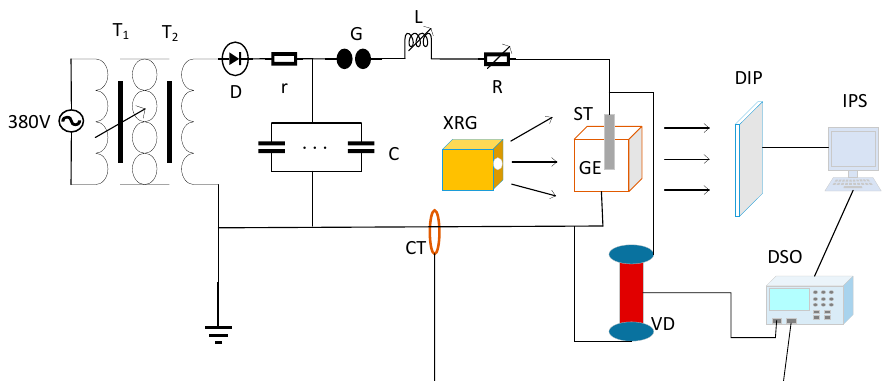
Figure 2. Sketch of the impulse current test setup: T 1 : Voltage regulator; T 2 : Voltage booster; D: Rectifier; r: Protective resistance; C: Charging capacitor bank; G: Sphere gap; L: Wave modulated inductance; R: Wave modulated resistance; XRG: X-ray generator; CT: Electric current transducer; ST: Sample sandbox; GE: Grounding electrode; VD: Voltage divider; DIP: Digital imaging plate; DSO: Oscilloscope; IPS: Image processing